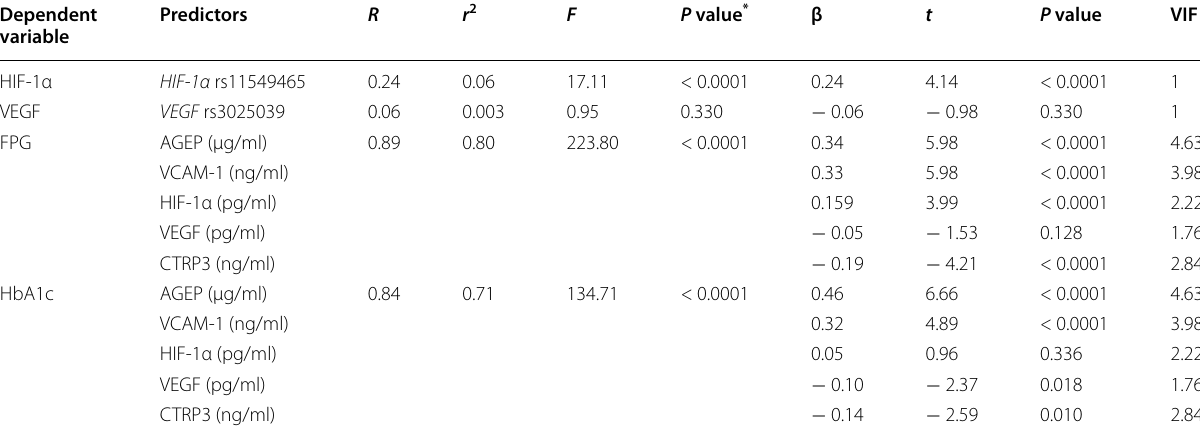
Table 6 Multiple linear regression analysis for the association of SNPs with their protein levels as well as serum levels of biomarkers with both FBG and